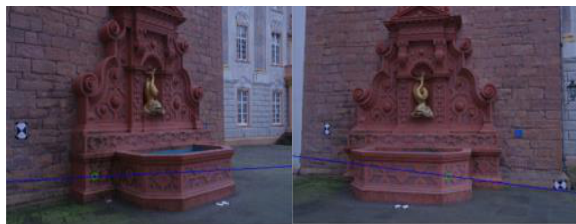
Figure 2. An instance of remaining outliers by using RANSAC on the wide-baseline images